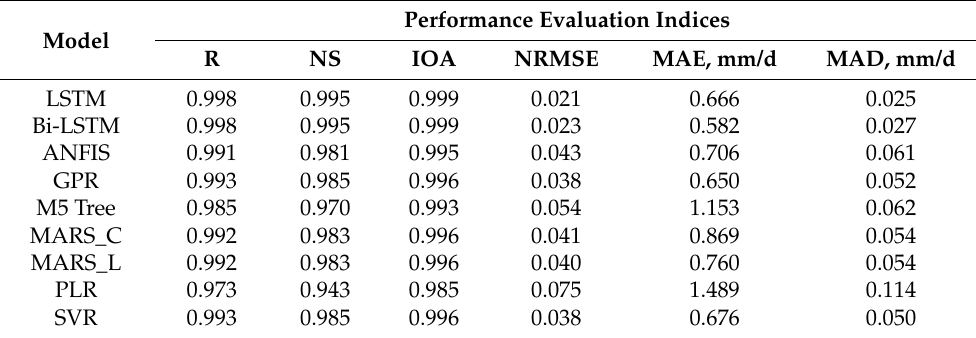
Table 7. Performance indices of the developed ET 0 prediction models for the testing dataset. Model